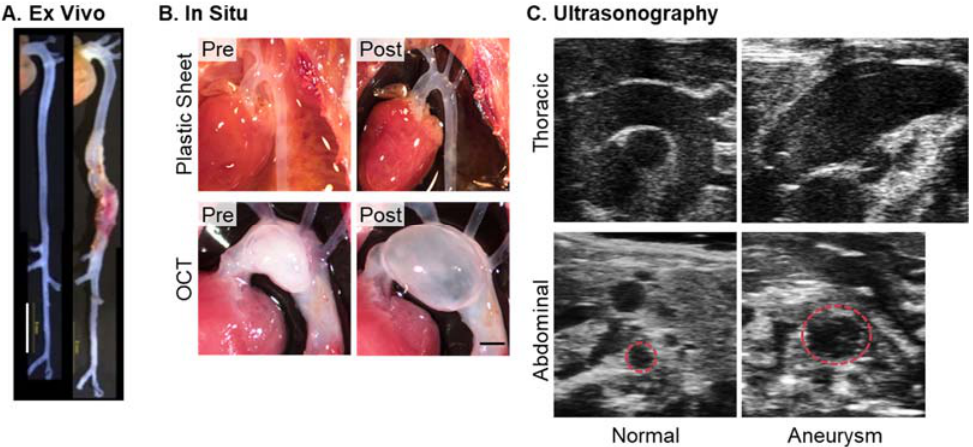
Figure 2. Examples of aortic images in mice. Representative images of ( A ) ex vivo [95] and ( B ) in situ approaches (authors’ unpublished data and the work of [105]), and ( C ) ultrasonography [14]. Ultrasound images were captured by Vevo 2100 with an MS550D (40 MHz). For in situ imaging, a piece of black plastic sheet was placed behind the aorta to enhance the contrast of the aortic wall. Subsequently, O.C.T. (optimal cutting temperature, 100–150 μ L) compound was injected from the left ventricle using an insulin syringe (31G). Scale bars in Figure ( A ) and ( B ) indicate 5 and 1 mm, respectively.